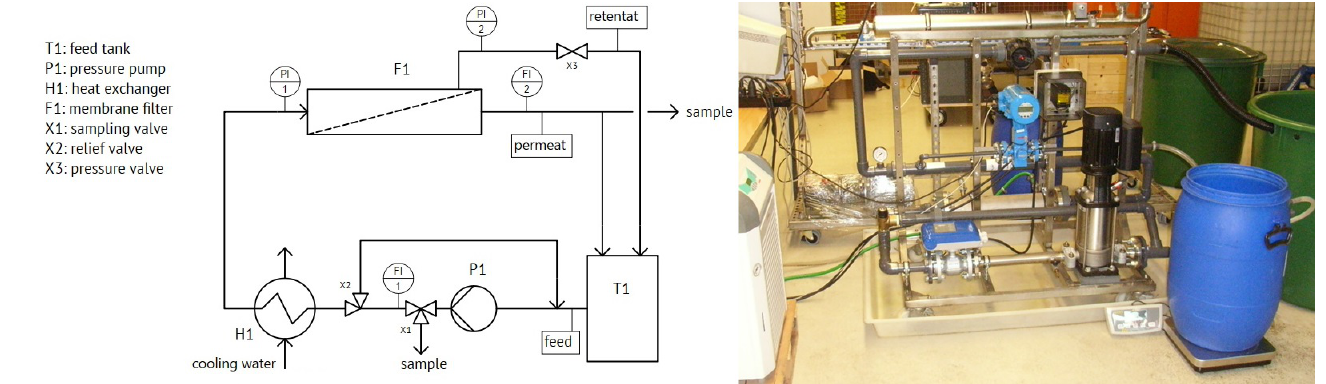
Figure 3. Ultrafiltration bench-scale